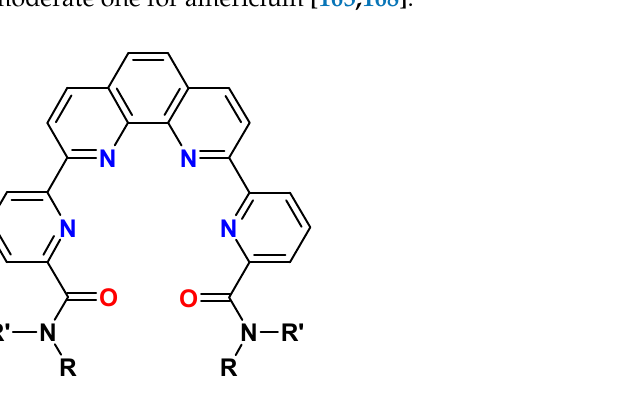
Figure 10. Diamides of 1,10-phenanthroline-2,9-(2-dipyridyl)-6,6′-dicarboxylic acid